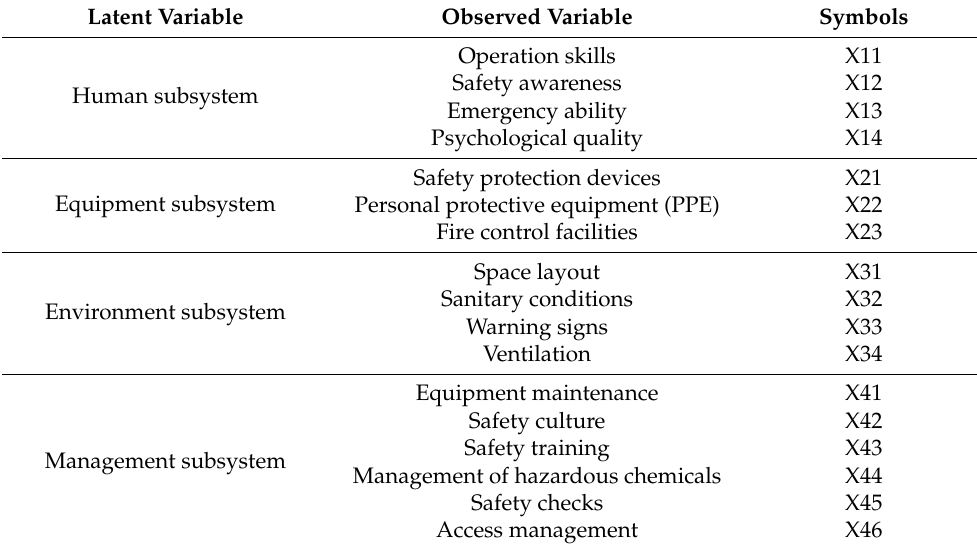
Table 1. Latent and observed variables in the